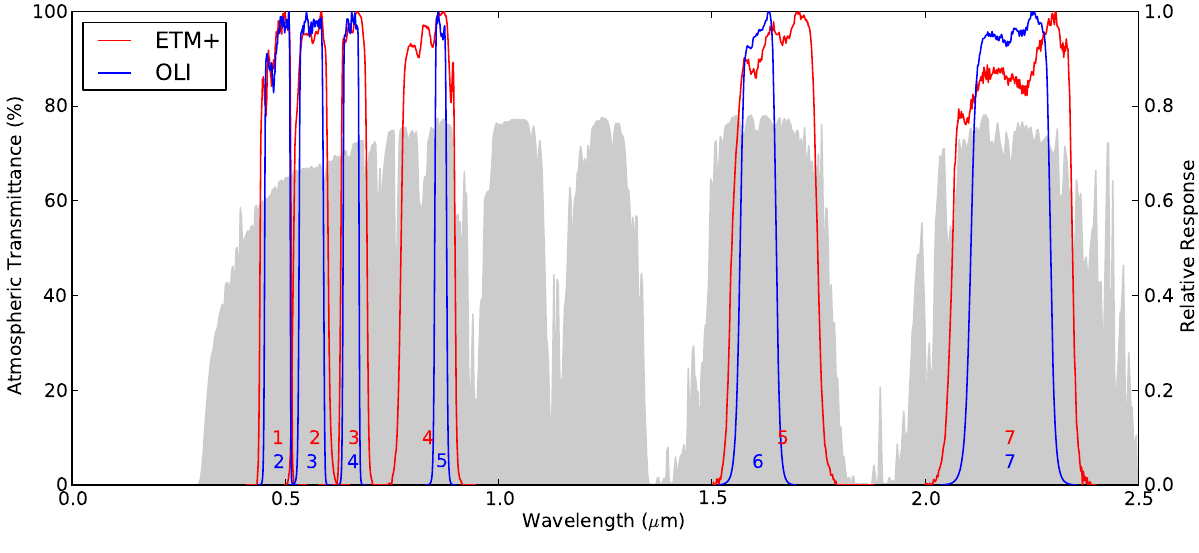
Figure 1. Relative spectral response functions for Landsat-7 Enhanced Thematic Mapper (ETM+) and Landsat-8 OLI reflective bands. The spectral response for each band is shown with the band number in the same colour. The values correspond to the scale on the right hand axis. The gray background fill is the atmospheric transmittance for the same wavelengths, as per the left hand axis. The atmospheric transmittance was modelled using